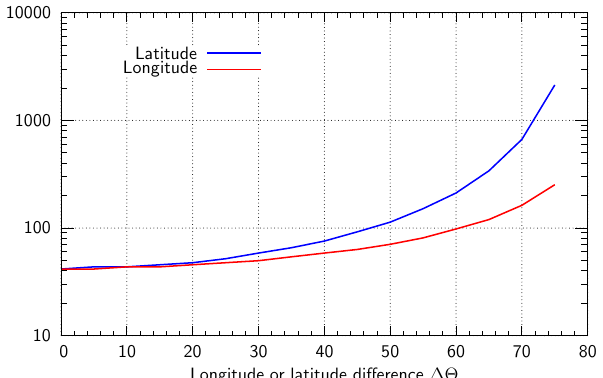
Fig. 17. Number of images of a power plant plume required to reduce the error in the estimated rate of CO 2 emission to 1MtCO 2 yr − 1 as a function of difference in latitude (blue) or longitude (red), assuming that the wind blows from the west with speed 5ms − 1 and the standard error in estimates of X CO